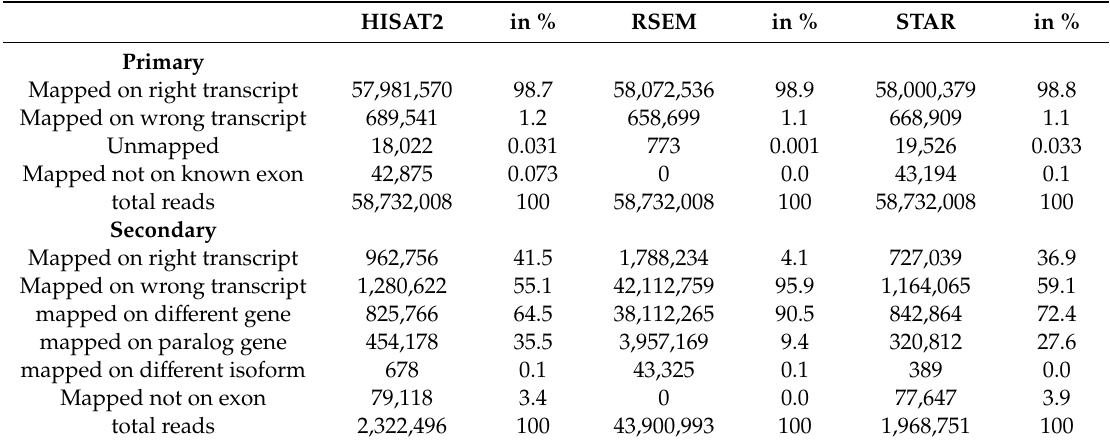
Table 5. Mapping of the in silico-generated Col-0 transcriptome using HISAT2, RSEM and